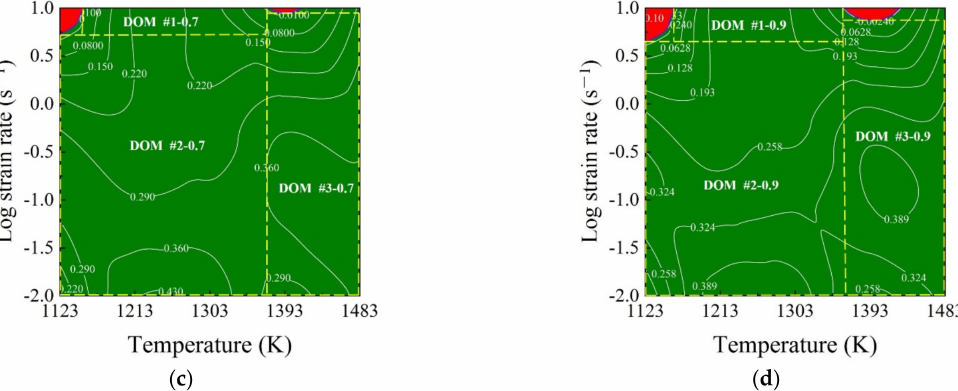
Figure 10. 2D processing maps for different true strains of ( a ) 0.3; ( b ) 0.5; ( c ) 0.7; and ( d ) 0.9.